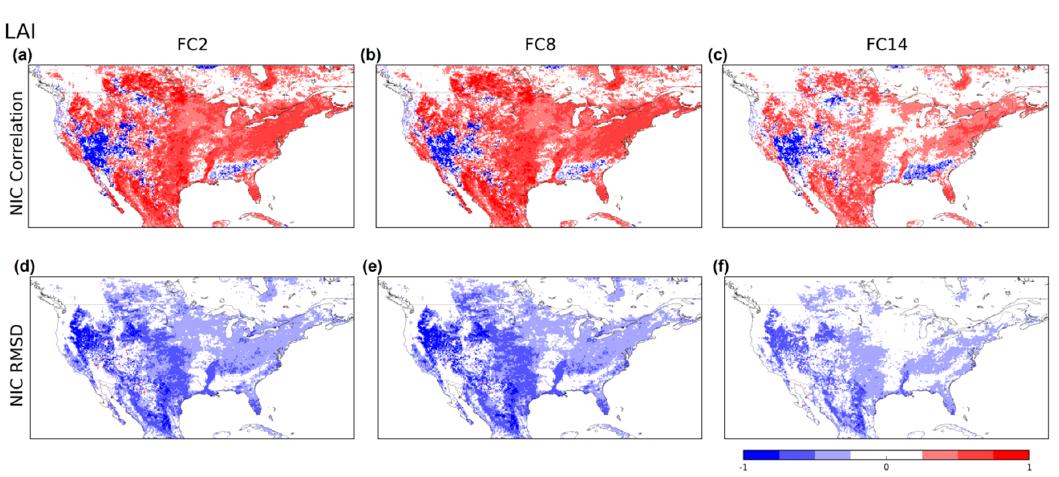
Figure 8. Same as Figure 7, except for simulated LAI and CGLS LAI. Spatial patterns of persistence of SEKF impact on simulated SSM as compared to CGLS SSM as forecast lead time increases. Upper row of maps shows NIC R values at FC2 ( a ), FC8 ( b ), and FC14 ( c ). Bottom row of maps ( d – f ) is the NIC RMSD values at the same forecast lead times. Note that red color for correlation is improvement from assimilation, whereas blue is improvement for